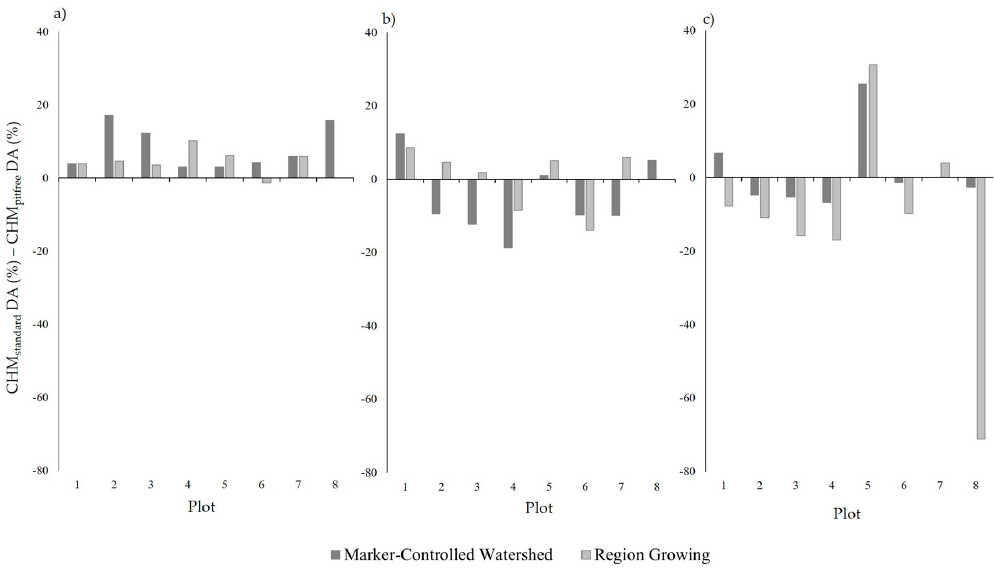
Figure 5. The difference between the CHM standard and CHM pitfree delineation accuracy (DA) percentages for each of the segmentation methods across the: ( a ) 0.15 m; ( b ) 0.25 m; and ( c ) 0.5 m pixel sizes. Table 9. p values from the Wilcoxon signed rank test after Holm–Bonferroni correction comparing results from the two CHM generation methods (standard and pit-free). * Denotes values significant at the 90% confidence level ( p < 0.10).